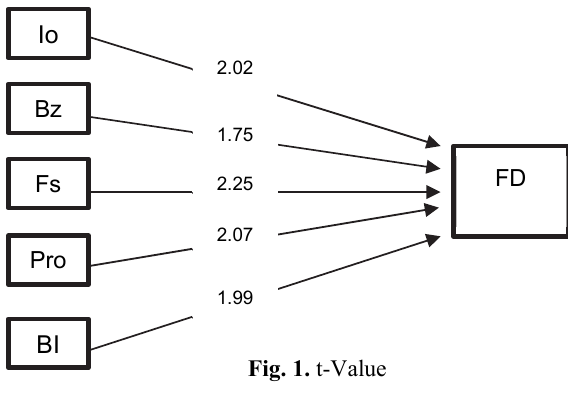
Fig. 1. t-Value Source: The result of data processing by LISREL